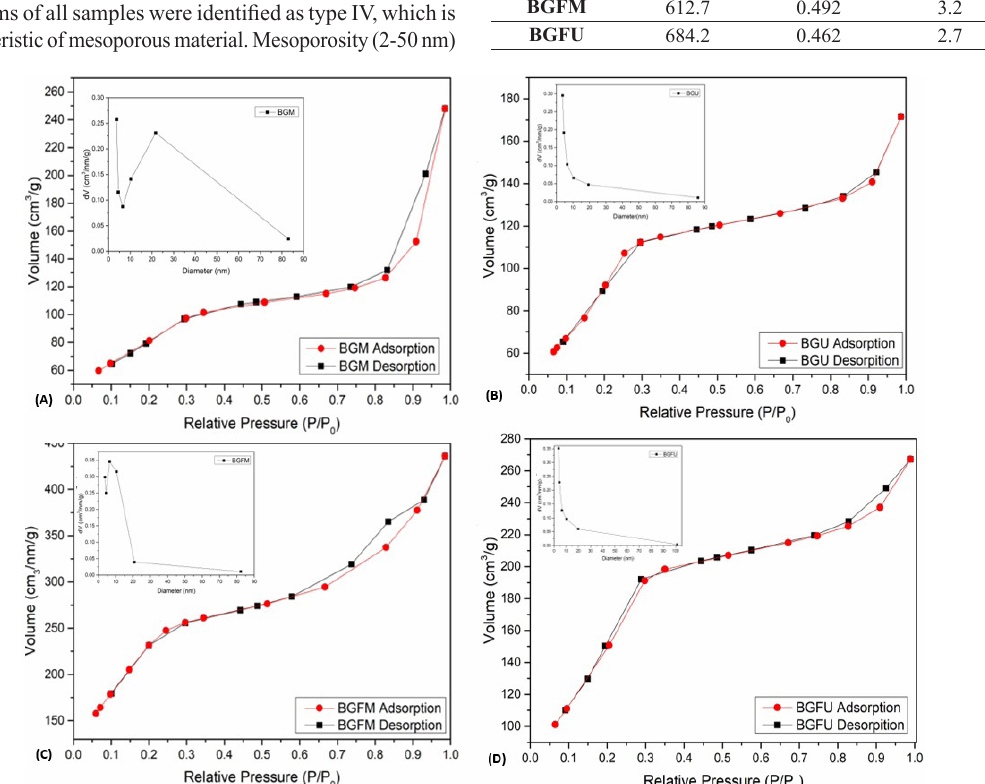
Figure 6. N s orption isotherms and pore size distributions of a BGM, BGU, BGFM and BGFU. 2